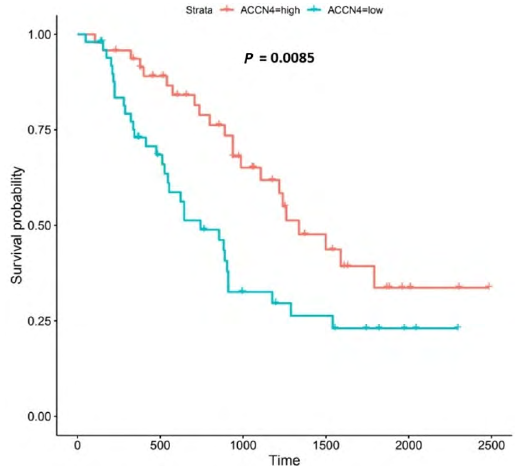
Figure 11. Kaplan-Meier survival plot for ACCN4 . Details as described in Figure 6